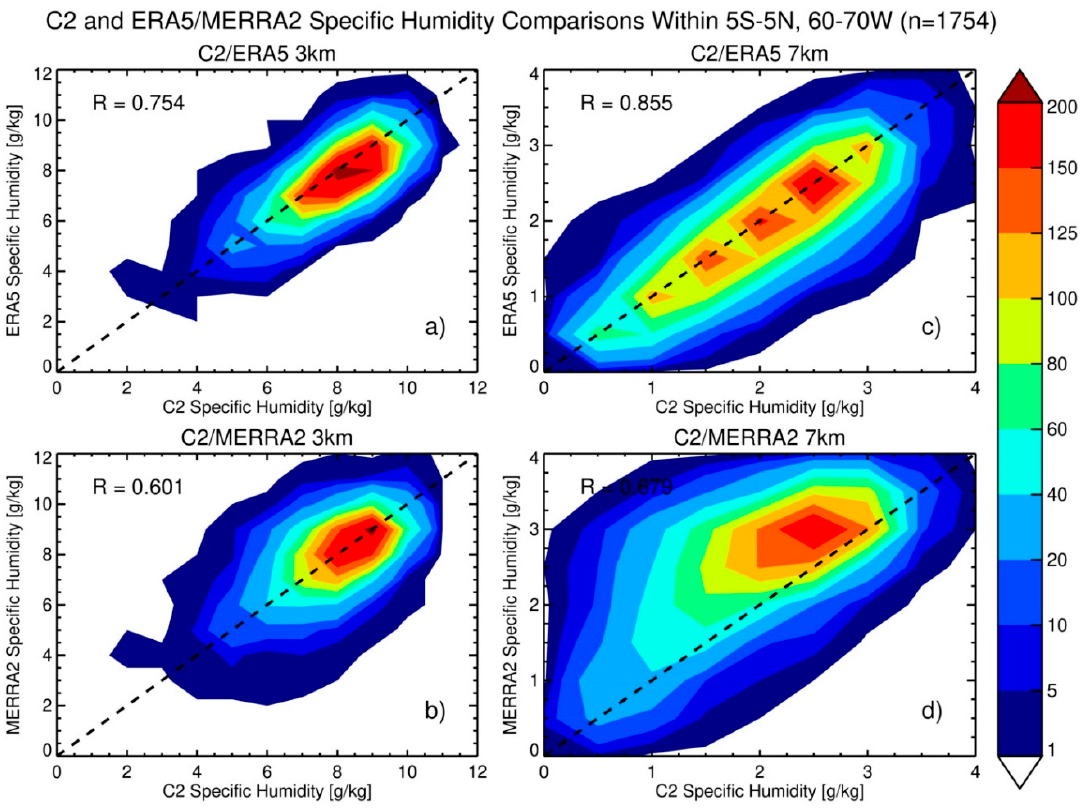
Figure 11. ( a , c ) Sampling distribution of C2 and ERA5 specific humidity at 3 km and 7 km, and ( b , d ) sampling distribution of C2 and MERRA-2 specific humidity at 3 km and 7 km within 5° S–5° N, 60° W–70° W from September–December 2019. The number of collocated profile pairs is shown in the title and the correlation coefficient is also shown on each panel.